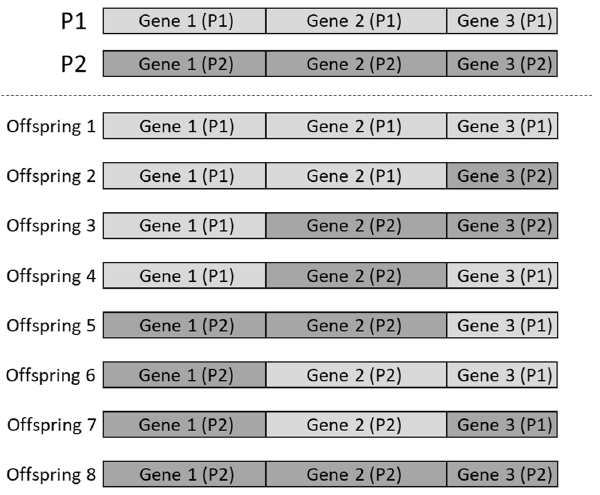
Figure 1. The illustration of the crossover operator.